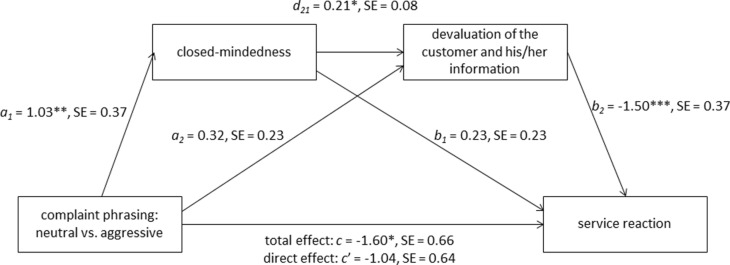
Closed-mindedness (mediator one) and devaluation of the customer and his/her information (mediator two) mediated the effect of complaint phrasing (neutral vs. aggressive) on service reaction in study 1. The mediation analysis was conducted using PROCESS (model 6, Hayes, 2013, p. 446). Coding of the independent variable “complaint phrasing” was neutral = 0 and aggressive = 1. The dependent variable “service reaction” is a difference measure by subtracting the preference for degrading service reaction from the preference for the favorable service reaction. a1, a2, b1, b2, c, c′, and d21 are unstandardized regression coefficients. *p < 0.05, **p < 0.01, ***p < 0.001.